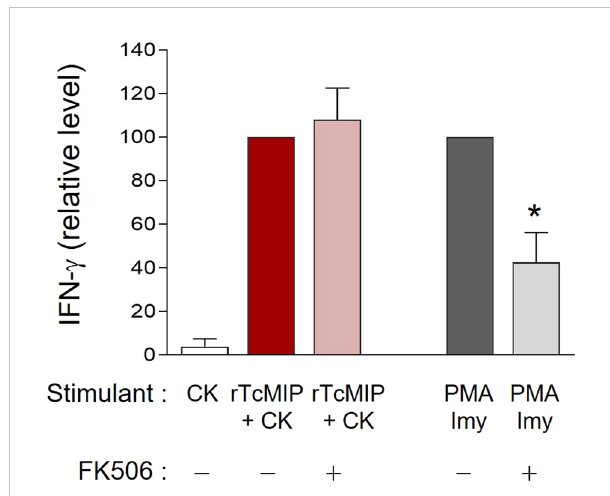
FIGURE 7 The rTcMIP bioactivity is independent of its PPIase enzymatic activity. Ten-fold diluted whole cord blood samples were cultured with rTcMIP (2.5 µg/mL), IL-2 (5U/mL) and IL-18 (10ng/mL) in the presence or not of FK506 (25 ng/mL). IFN- g were measured in the supernatants by ELISA after 72h. Results are expressed as mean ± SEM (n=6). *P< 0.05 as compared to the absence FK506 (Wilcoxon